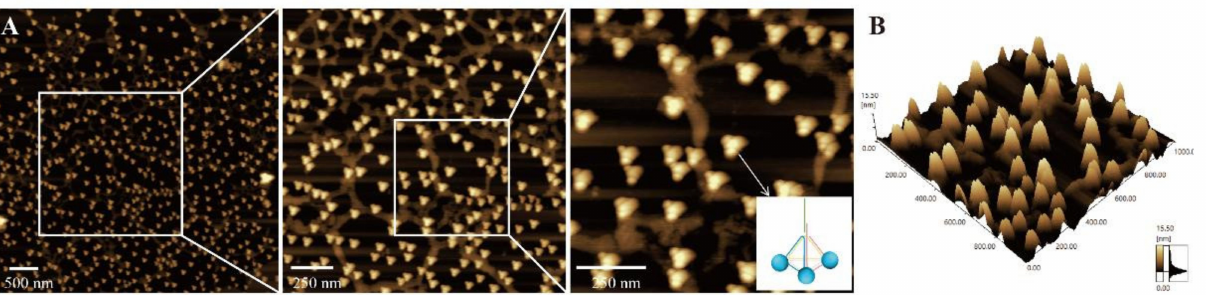
Figure 5. AFM result of Td − bCD. ( A ) Topview AFM images of Td − bCD, the field of view decreases from left (5 µ m) to right (1 µ m); ( B ) Td − bCD size distribution of the third image in ( A ).